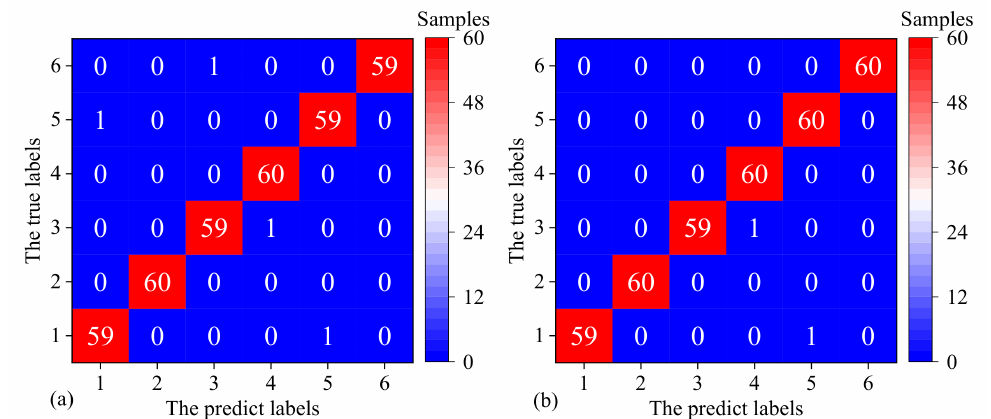
Figure 15. The fault diagnosis confusion matrixes by utilizing the SVM classifier of the 360 PMDCM samples (each category has 60 samples) with the 136 selected features by the VTFS method ( a ), and with the 238 selected features by the GVFS method ( b